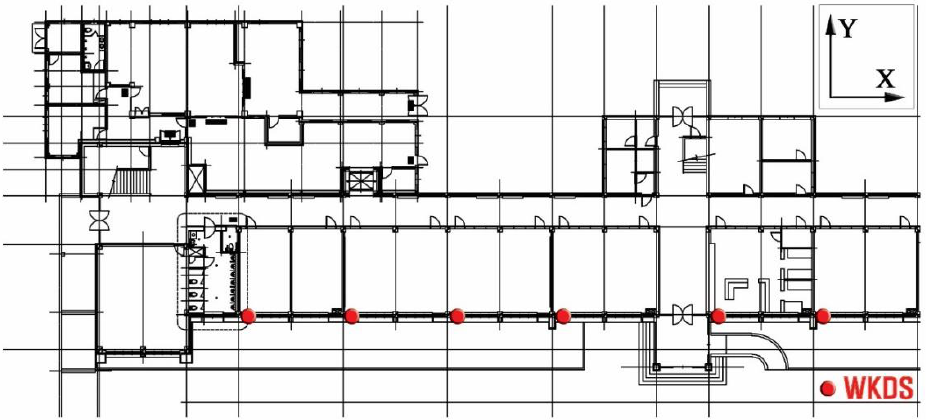
Figure 20. Architectural plan of a building model and location of strengthening with the WKDS.